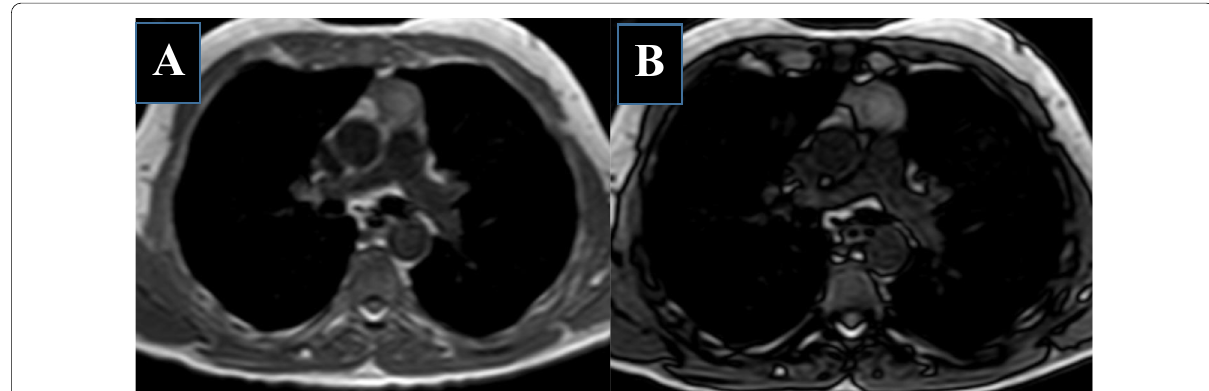
Fig. 5 MRI chemical shift imaging in a 34‑year‑old male patient complaining of drooping of both eyelids and weakness in both lower limbs diagnosed as MG. a In phase and b out of phase MR images show the mass eliciting intermediate signal to the surrounding muscles with no apparent signal drop in the out of phase series. CSR value is 1.01. Histopathological diagnosis was thymoma